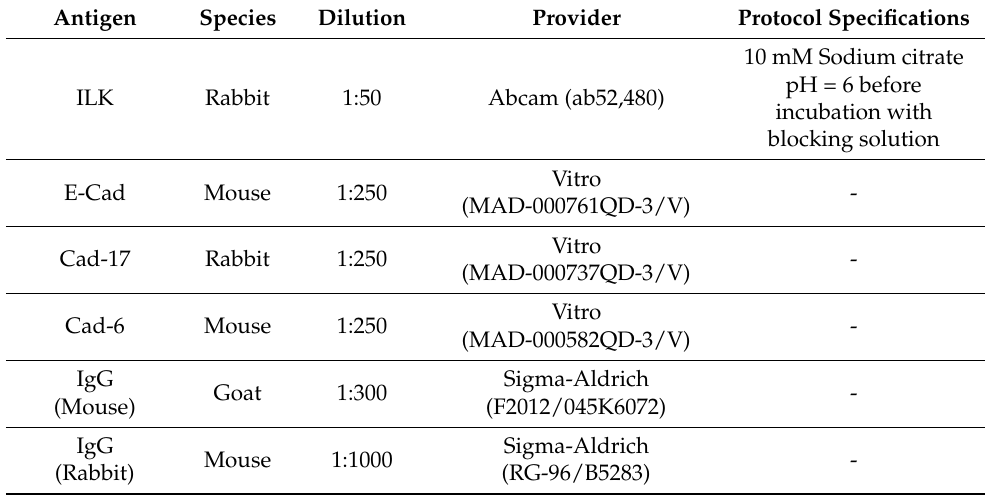
Table 3. Primary and secondary antibodies used in the immunohistochemical studies performed, showing the dilutions used and the protocol specifications.